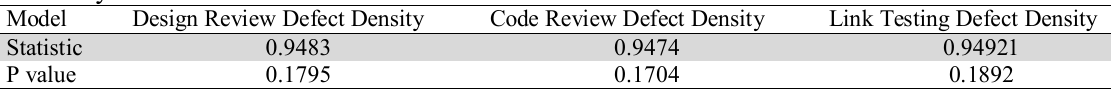
Normality test results